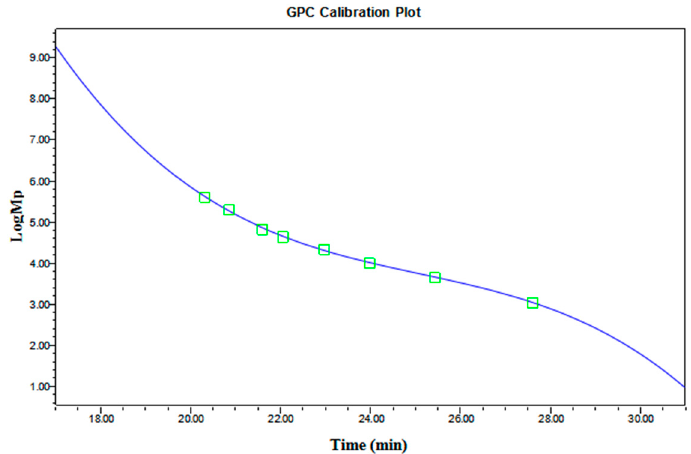
Figure 6. The standard curve of dextran.